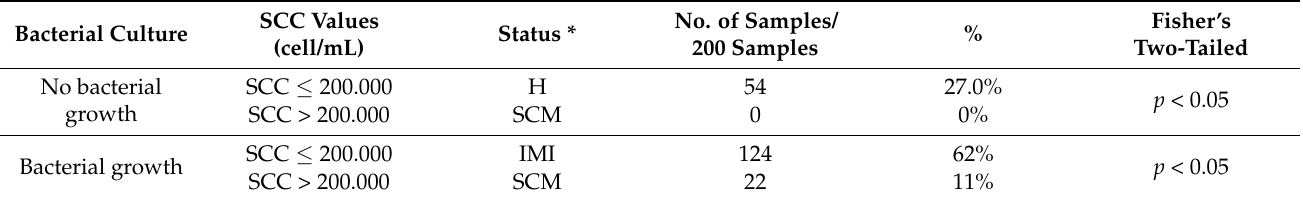
Table 4. Bacterial culture results and somatic cell counts (SCCs) in buffalo milk